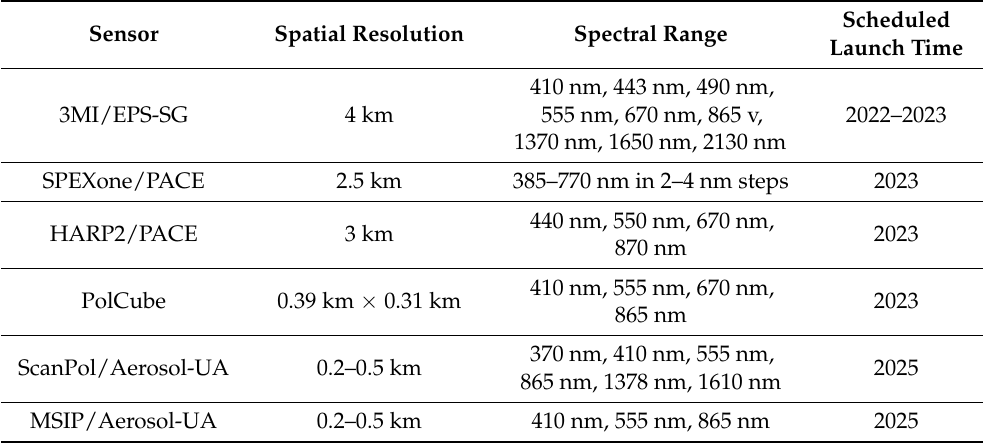
Table A2. Comparisons between future missions concerning optical polarization observation